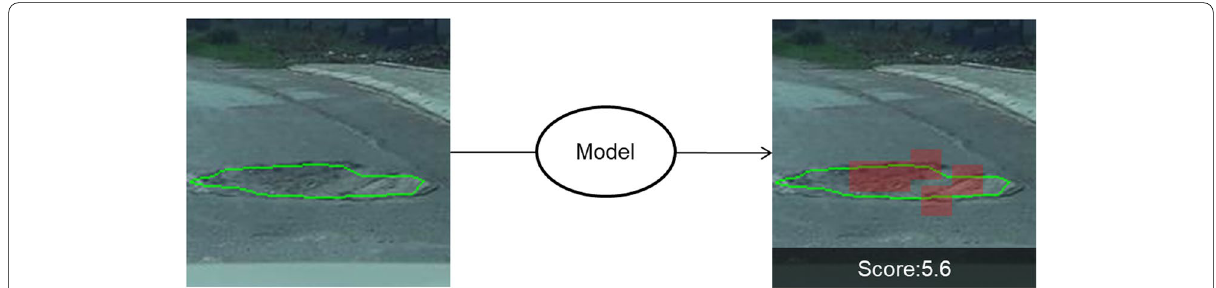
Fig 6 An example of input and output of manholes evaluation